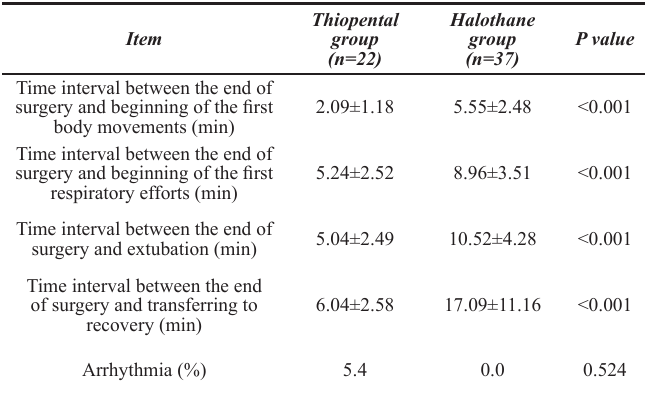
TABLE 3 - Comparison of heart rate between the patients received thiopental and halothane.